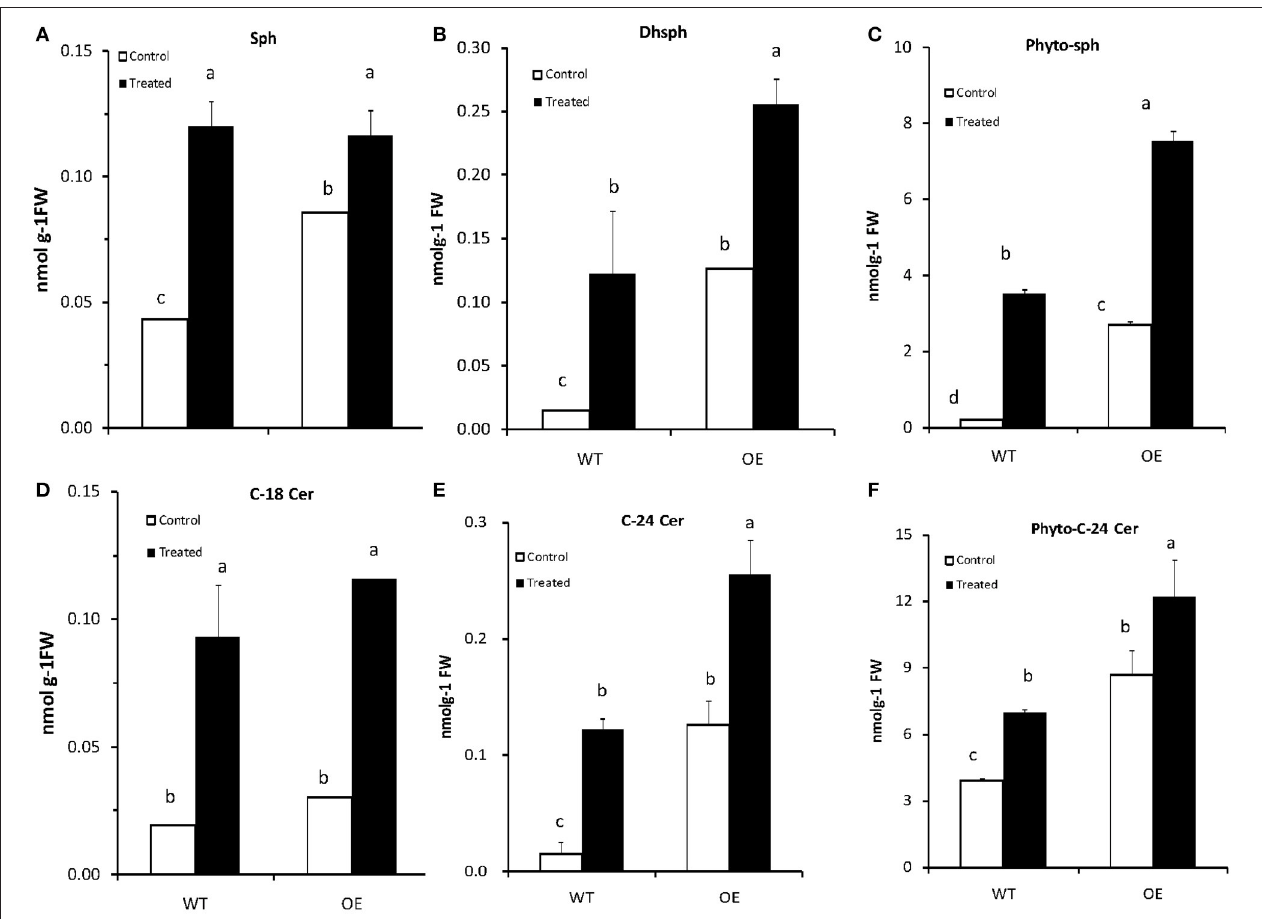
FIGURE 7 | (A–F) Content of (nmolg − 1 FW) different LCBs and Ceramides in Arabidopsis after treated with phytosphingosine. Four-week-old plants were sprayed with phytosphingosine or methanol as control (solvent of phytosphingosine) for 8h. Values are expressed as the mean ± SE of three independent experiments. Different letters indicate significant differences ( P < 0.05) among the treatments (Arabidopsis and phytosph treatments). Sph, sphingosine; Dhsph, dihydrosphingosine; Cer, ceramide; FW, fresh